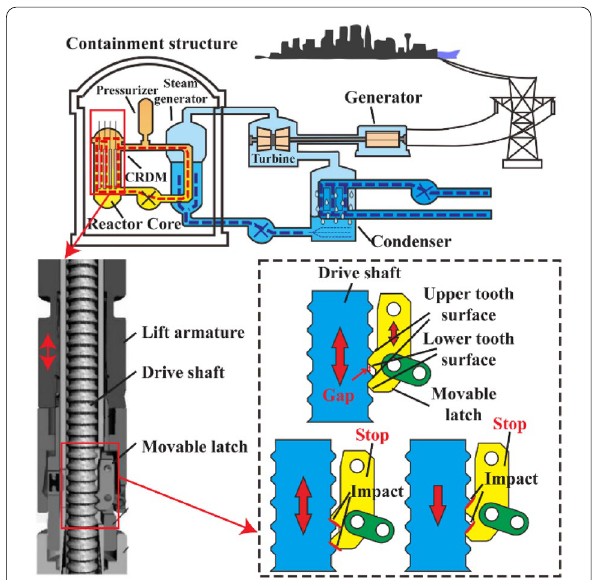
Figure 1 The main structure of movable latch